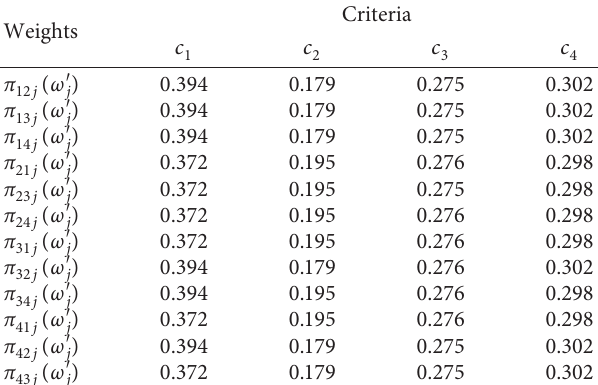
Table 11: Transformed probability weights.